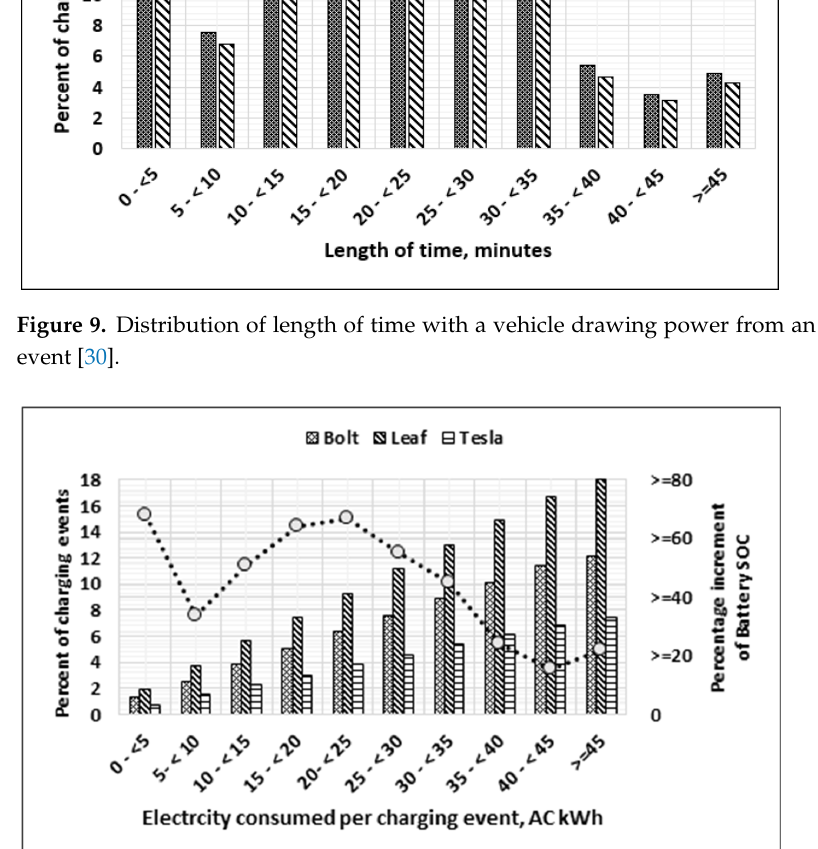
Figure 10. Battery state of charge at end of charging from an FCS prior to driving.